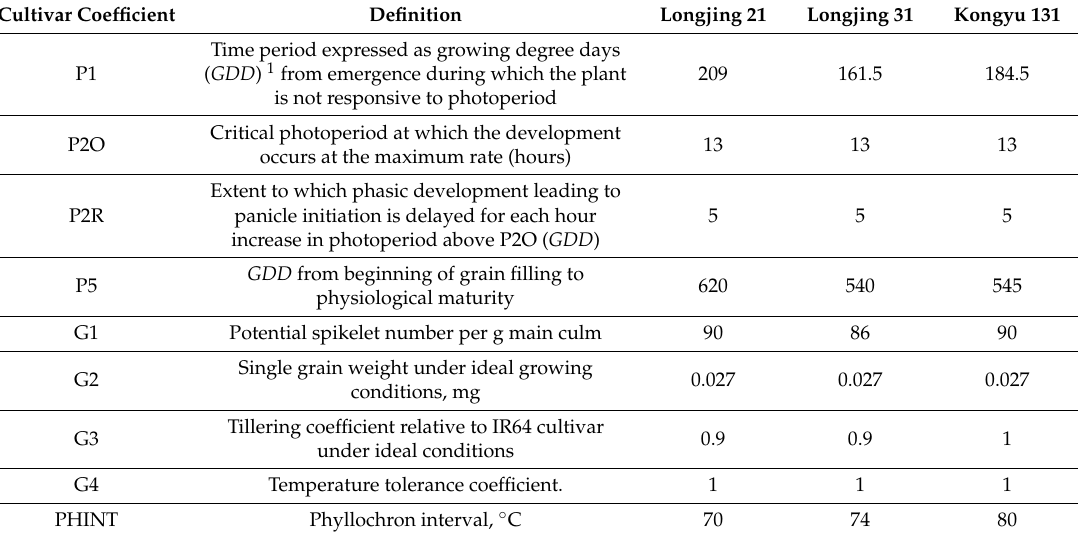
Table 1. Nine cultivar coefficients in CERES-Rice, calibrated for three